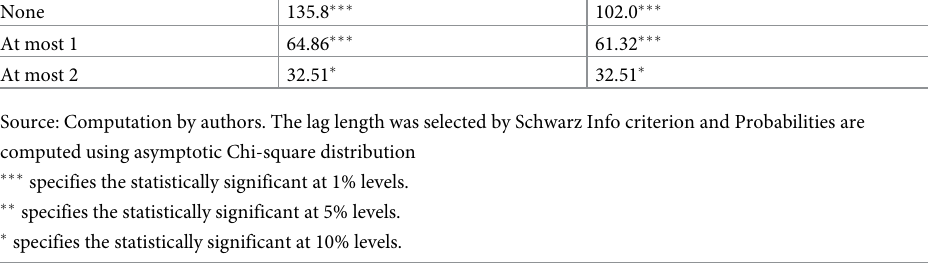
Table 11. Fisher (Combined Johansen) test. Hypothesized No. of CE(s) Fisher Stat. � (from trace